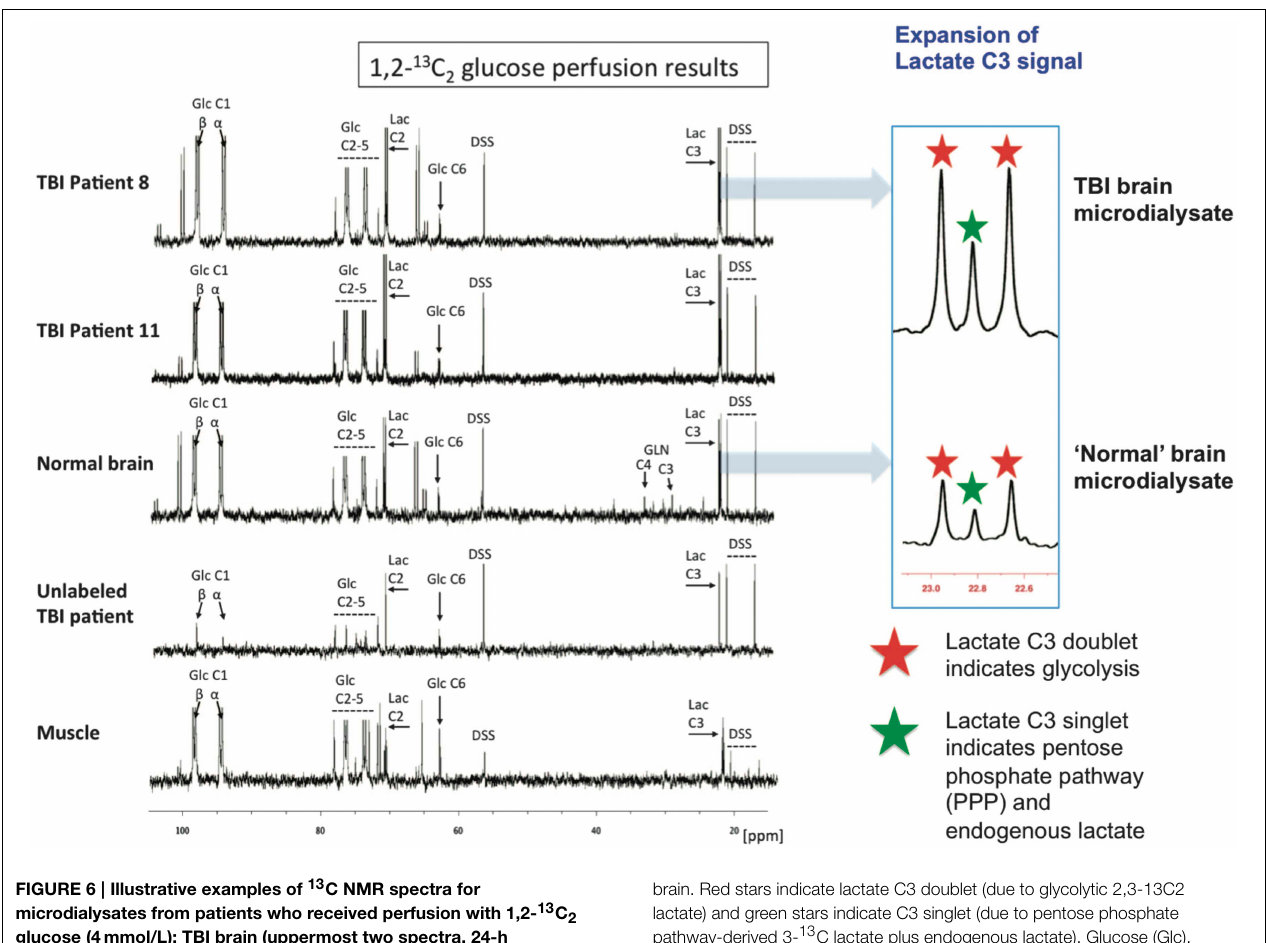
FIGURE 6 | Illustrative examples of 13 C NMR spectra for microdialysates from patients who received perfusion with 1,2- 13 C 2 glucose (4mmol/L): TBI brain (uppermost two spectra, 24-h perfusion), “normal” brain (third spectrum, 24-h perfusion), and muscle (bottom spectrum, 8-h perfusion). An example of brain microdialysate from an unlabeled TBI patient with plain (unsupplemented) perfusion fluid is shown for comparison (fourth spectrum). Examples of expansion of the lactate C3 signal are shown for TBI brain and “normal”